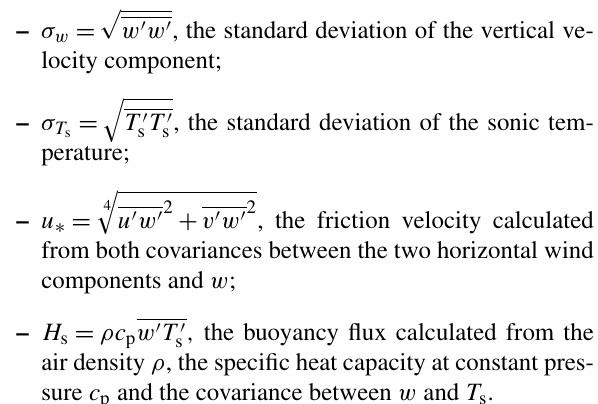
Figure 3. Meteorological elements during the intercomparison experiment; 30 min averages of air temperature ( T ) and net radiation ( R n ) measured at 2m, and wind speed ( u ) and direction (dir) from the DE-Fen site measured at